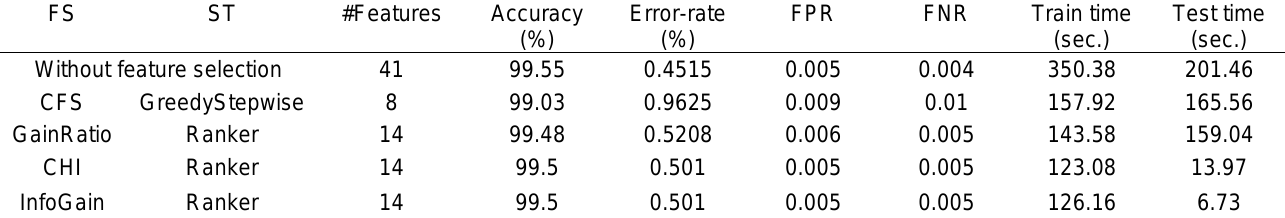
Table 11. Performance evaluation of Majority Voting classifier using and without using feature selection techniques on NSL-KDD dataset